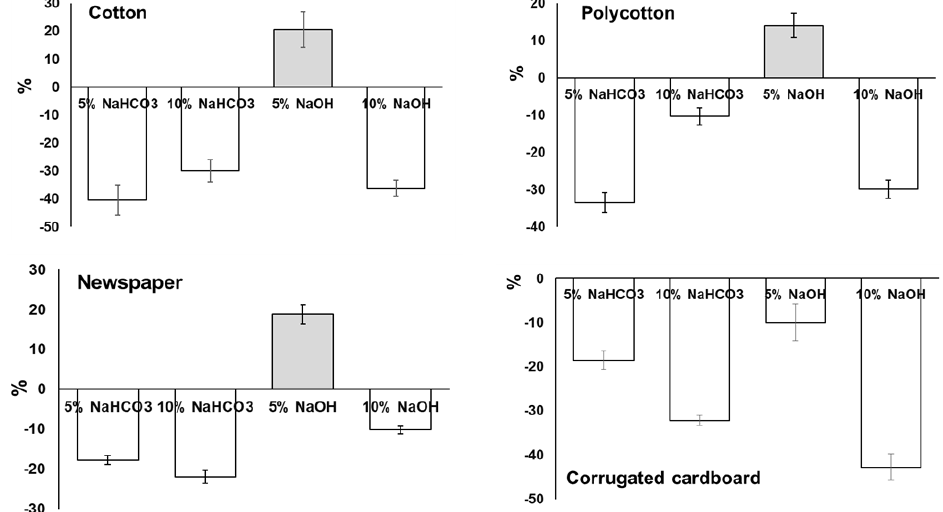
Figure 2. Percent increase or decrease in tensile strength of alkali treated substrates (error bars indicate standard error of the mean).